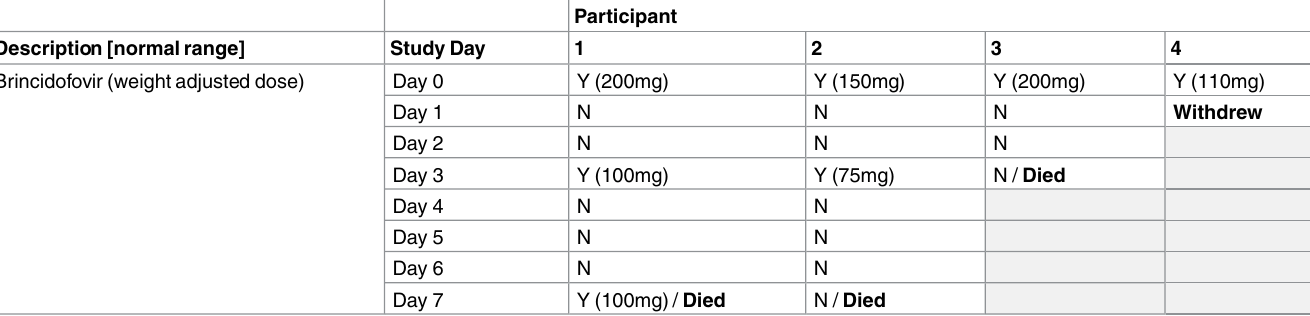
Table 2. Treatment and clinicalprogression